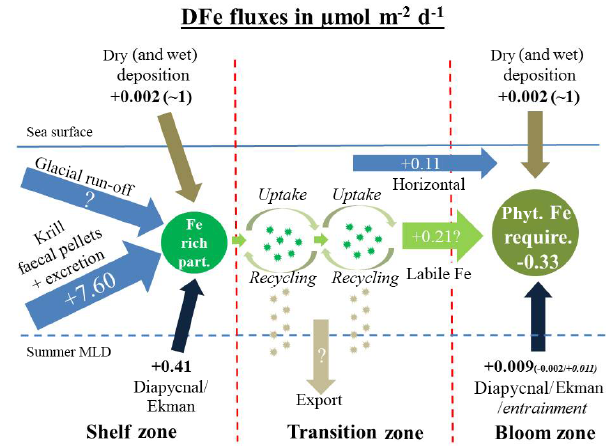
Figure 8. Sketch of DFe fluxes on the shelf, in the transition zone, and in the downstream blooming region, separated by the red dashed lines. (left sketch) The dissolved Fe fluxes on the shelf that together generate Fe rich biogenic and lithogenic particles (dark green). These are transferred offshore (light green arrows) following the ACC to open-ocean sites (sketch in the middle). Iron-enriched particles (dark green) in the transition zone are recycled and sup- plement DFe requirements of the phytoplankton community in the transition zone. During each cycle of recycling and uptake an un- known Fe fraction is lost by vertical export. (right sketch) The dis- solved Fe fluxes in the blooming